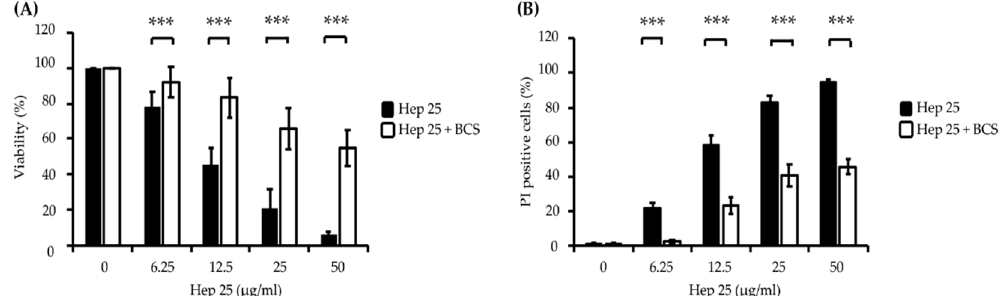
Figure 5. The effect of BCS on the candidacidal activity of hep 25. ( A ) Killing of C. albicans cells by hep 25 cotreated with or without 1 mM BCS was determined by the number of CFUs and expressed as the percentage of viable cells; *** p < 0.001. ( B ) The killing activity of hep 25 with or without 1 mM BCS was detected by PI staining. The cells killed by hep 25 with or without 1 mM BCS were quantified by flow cytometry and reported as a percentage. The results are presented as the mean ± standard deviation of three independent experiments; *** p < 0.001.